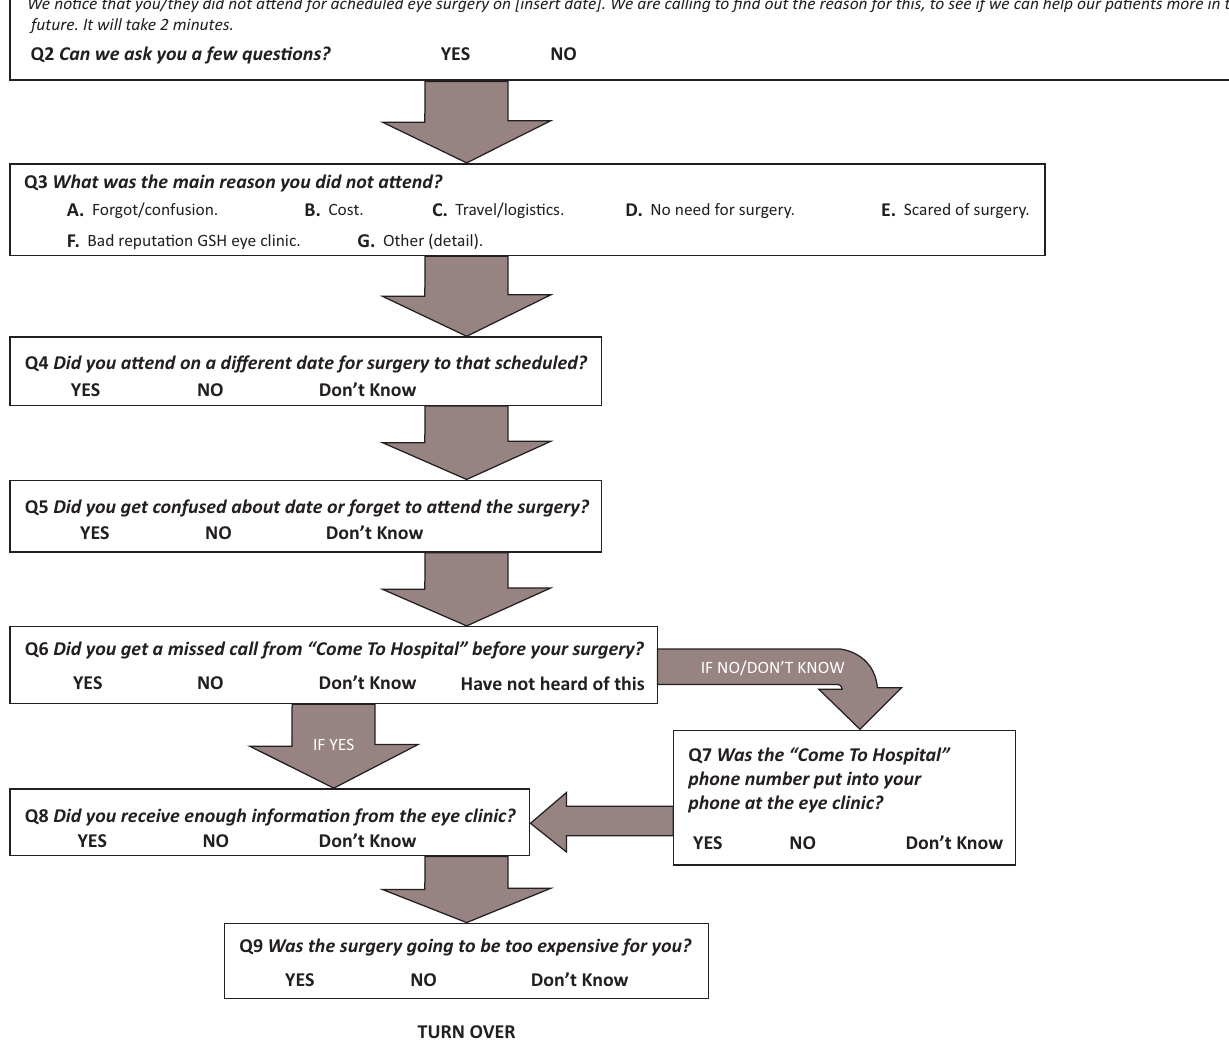
FIGURE 1-A1: Questionnaire – Non-attending eye theatre patient.